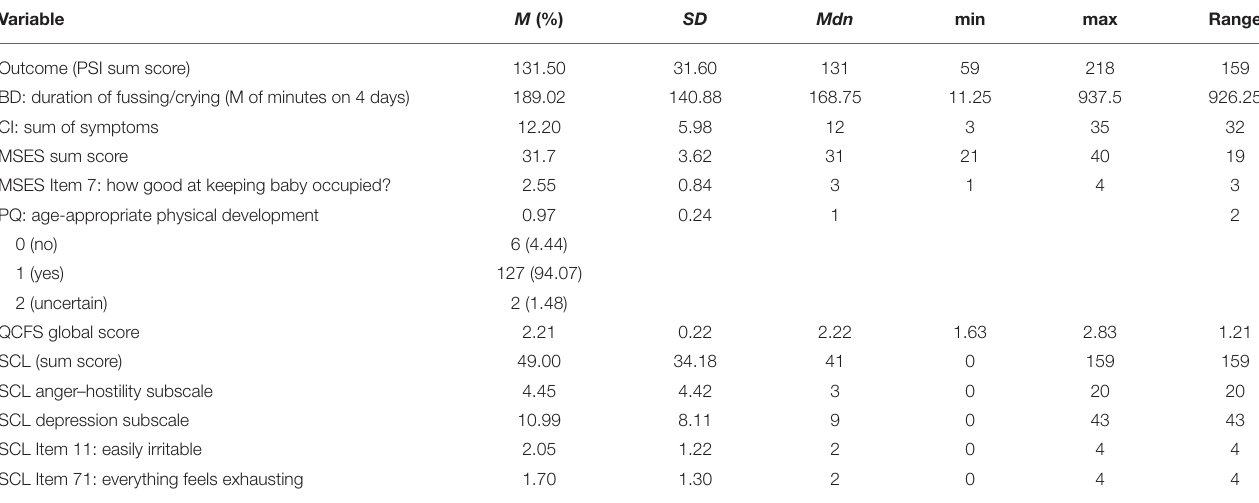
TABLE 2 | Descriptive statistics of the PSI outcome and the top 11 most important variables for the prediction of PSI.